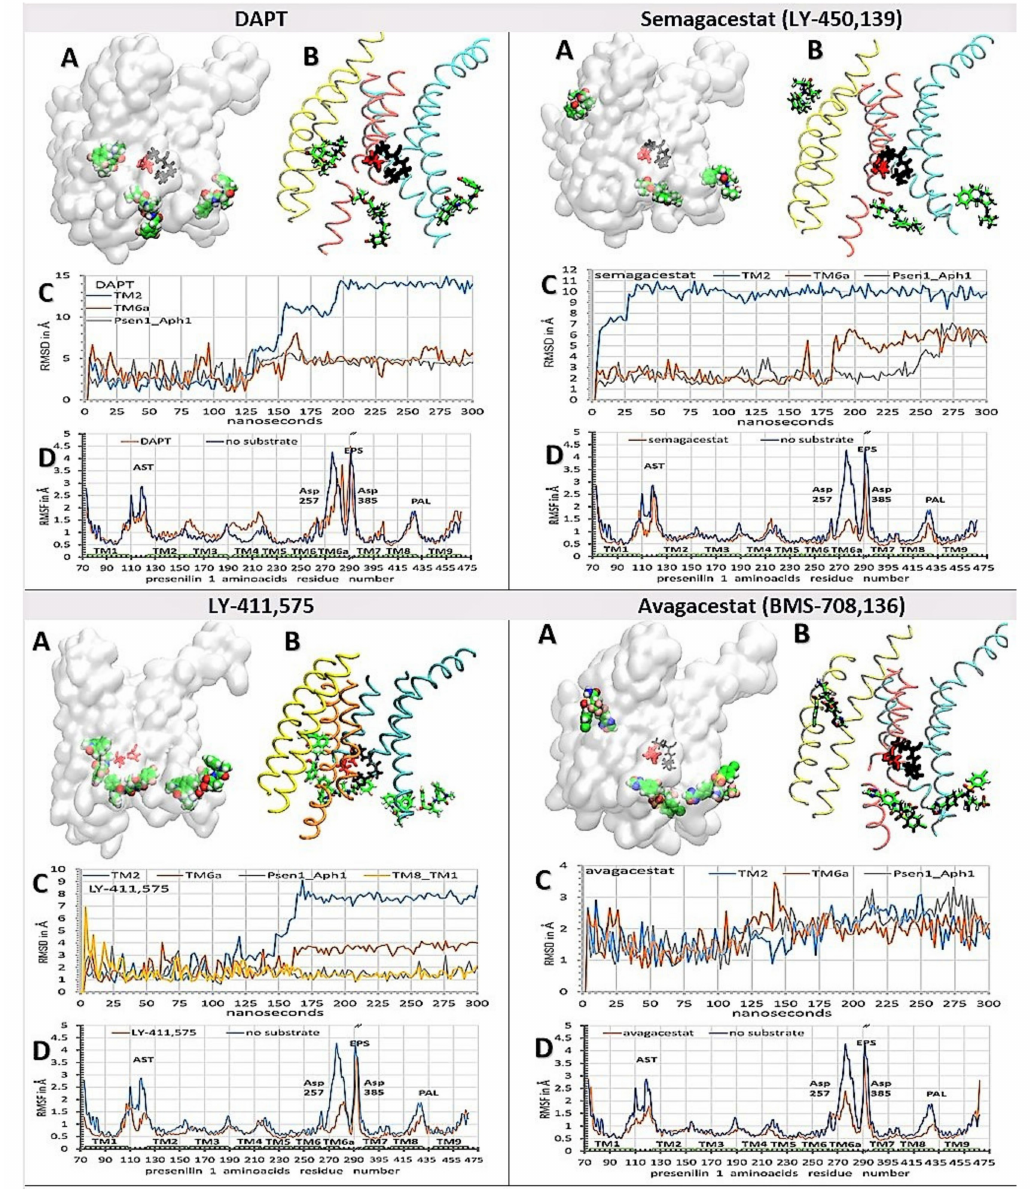
Figure 6. ( A – D ) Binding interactions between the biphasic drugs and γ -secretase in the absence of a substrate [38,39]. The all-atom molecular dynamics studies [51] started with γ -secretase in a complex with different biphasic drugs from the molecular docking calculations (Figure 4) [48]. ( A , B ) Different drugs can penetrate into the active site tunnel to a different extent. The presenilin structures are shown as transparent surface ( A ). TM2 and TM3 are shown in yellow; TM6, TM6a, and TM7 are shown in orange; TM8, TM9, and TM1 are shown in cyan ( B ). Buried under the presenilin surface are active site Asp 257 and Asp 384 (red licorice) and the PAL motif (Pro 435, Ala 434, Leu 433, black licorice) [42]. The drug molecules are shown as: carbon, green; oxygen, red; nitrogen, blue; fluorine and chlorine, pink. ( C ) The RMSD values for drugs bound at different sites are shown as a function of the simulated molecular time [51]. The steep increases in the RMSD values indicate the sliding of the drugs in their binding sites, while the fluctuations in the RMSD values indicate the relative mobility of the drugs in their binding sites. ( D ) The average RMSF values for the individual amino acids show changes in the protein mobility [40,41]. All four drugs can decrease the mobility at the specific sites in the presenilin structure to a different extent. Different structural elements are mapped on the graph. TM1-TM9, Trans-Membrane helix 1–9; AST, membrane-embedded opening of the Active Site Tunnel; EPS, Endo-Proteolytic Site; PAL, motif (a.a. 433 to 435) [42], and Asp 257 and Asp 385 in the active